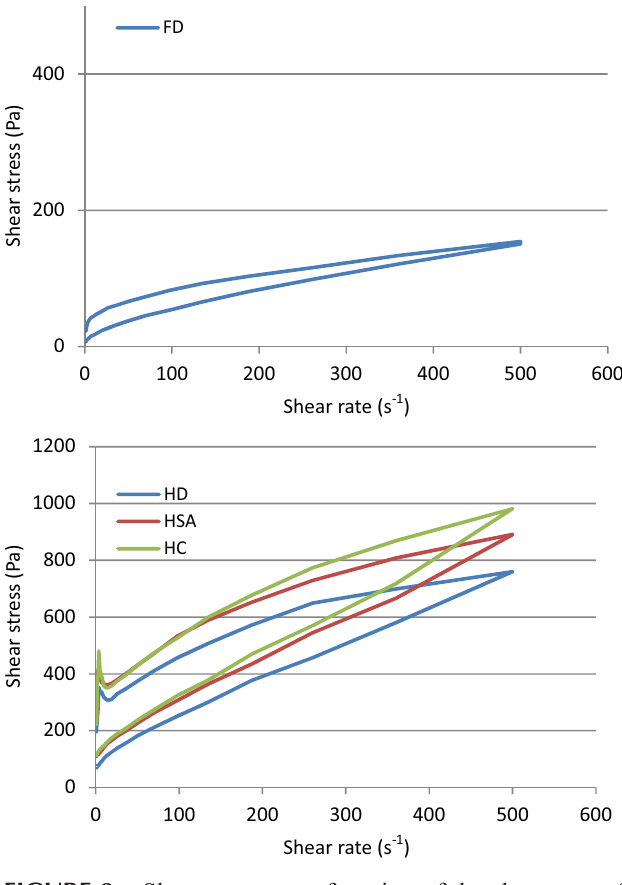
FIGURE 3 – Shear stress as a function of the shear rate of the semisolid formulations. Upper and lower curves present ascending and descending measurements, respectively, for each